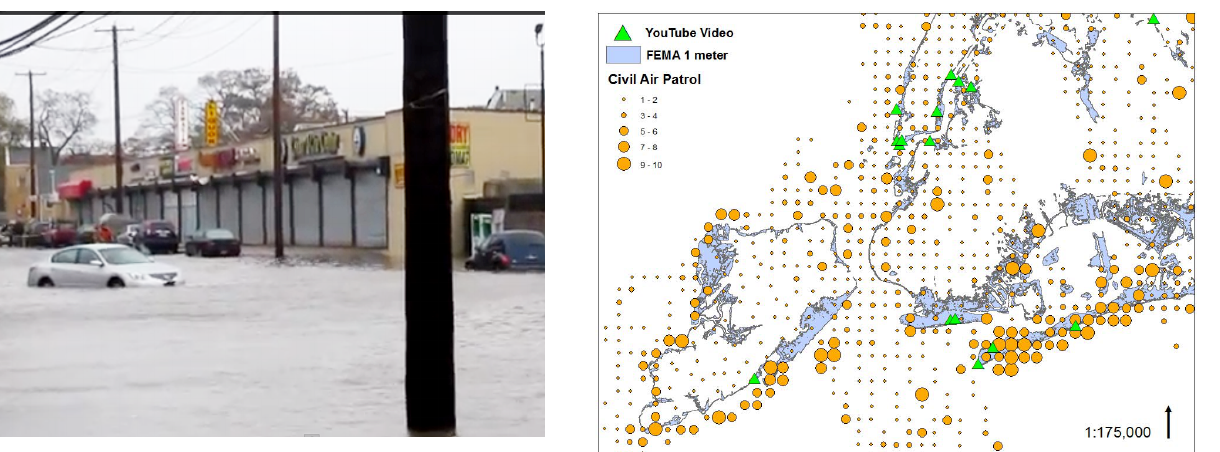
Fig. 7. Locations of Civil Air Patrol photos and geolocated videos documenting flooding.